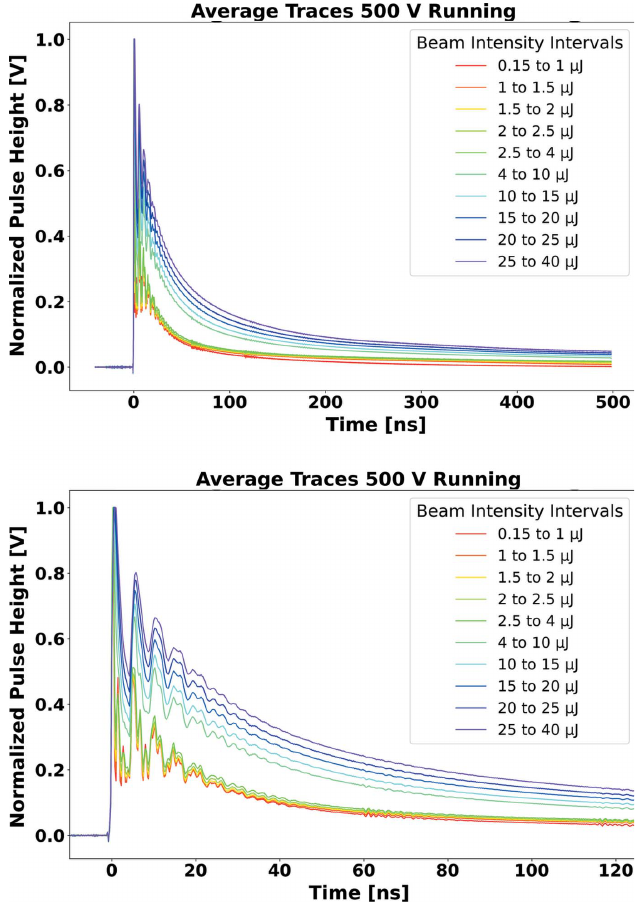
Figure 6 Average temporal signal profiles observed with the Sydor assembly, in bins of delivered pulse intensity. The top plot shows the full 500 ns digitization window; the bottom plot shows the pulse behaviour over the first 125 ns of the excitation, for the purpose of comparing with similar results from the SCIPP assembly (Fig. 7, top). To compare the temporal properties of the signal current, each pulse is normalized to the same maximum pulse height, which is arbitrarily set to a value of